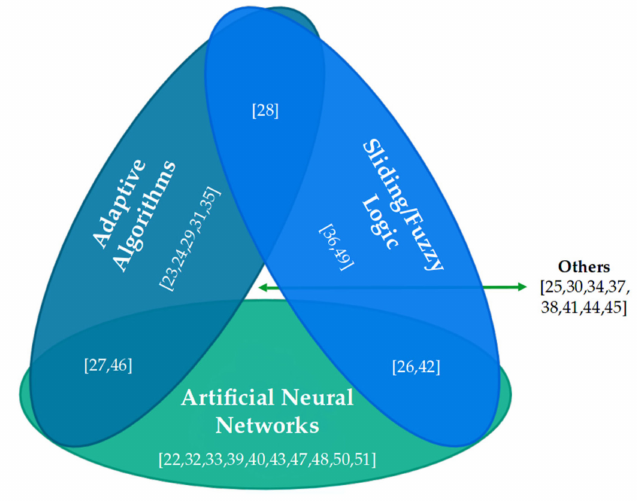
Figure 7. Subdivision of reviewed documents according to the type of AI-driven technique used for information processing or control